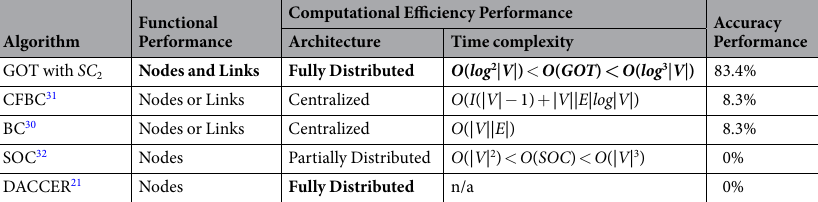
Table 1. Comparison of five centrality algorithms using different performance criteria (i.e. functional, computational efficiency, and accuracy). The bold values represent the best performer for specific performance